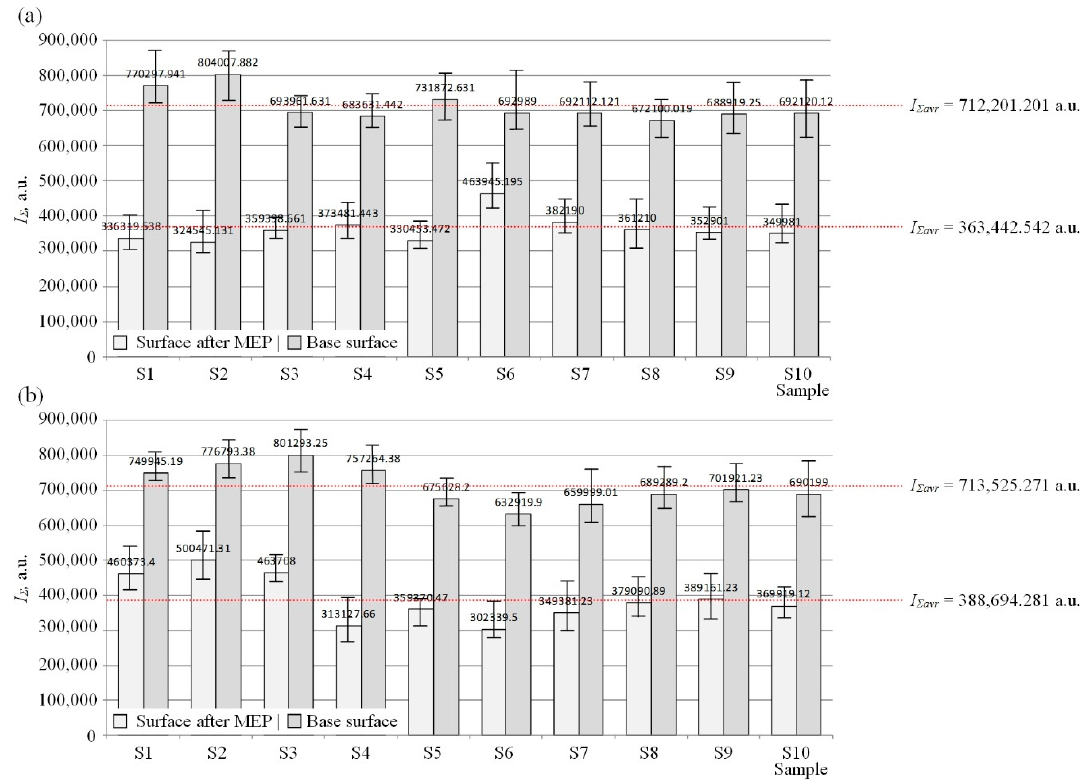
Figure 6. Average values of integrated optical density (of the bright regions of scattered light image) obtained for surface after the MEP process and base surface for samples ( a ) MEP-800; ( b ) MEP-50.